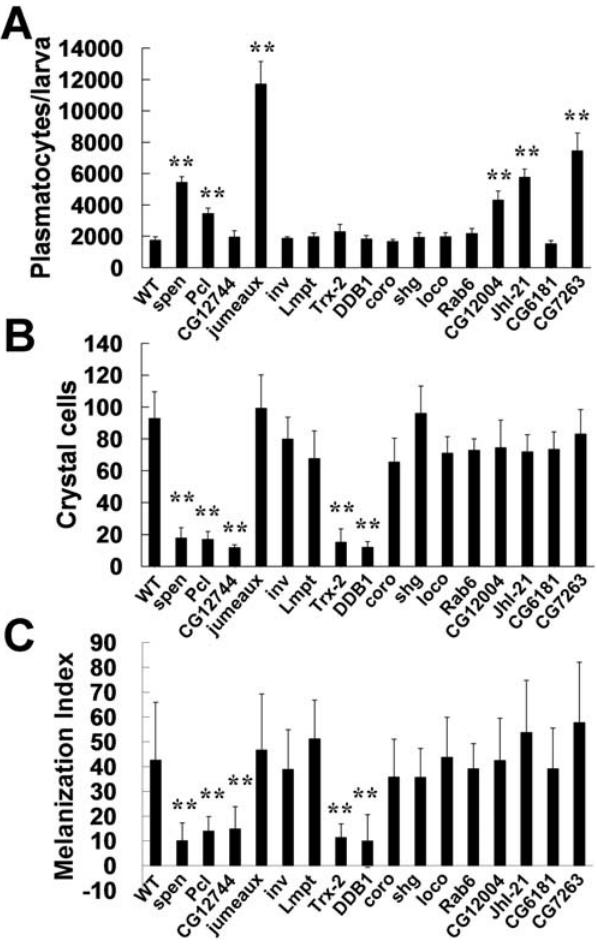
Figure 6. Analysis of Drosophila larval hematopoiesis. (A) Analysis of circulating plasmatocytes. Plasmatocytes were counted from at least six third instar larvae of each genotype; error bars represent the SD of the mean from 3–6 independent experiments. (B, C) Analysis of crystal cell development. (B) Third instar larvae were heated to 60 u C for 10 min in a water bath to visualize crystal cells through the cuticle. Crystal cell counts from the sessile population of the last two posterior dorsal segments of third instar larvae of the indicated genotype are shown. (C) Third instar larvae pricked with a clean standard needle led to a hemocoelic melanization reaction. Melaniza- tion index was derived by the area with the mean intensity of melanization signal measured. 12–20 larvae were analyzed for each genotype, error bars represent standard deviation. In each panel, p - values were calculated by Student’s t-test. ** p ,